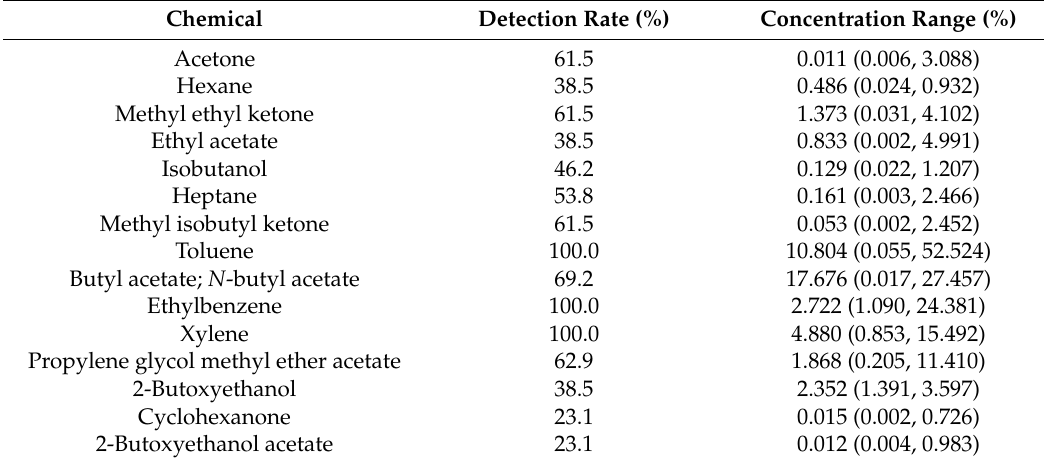
Table 3. Detection rate and concentration (median, minimum, and maximum) of target chemicals in car colorant